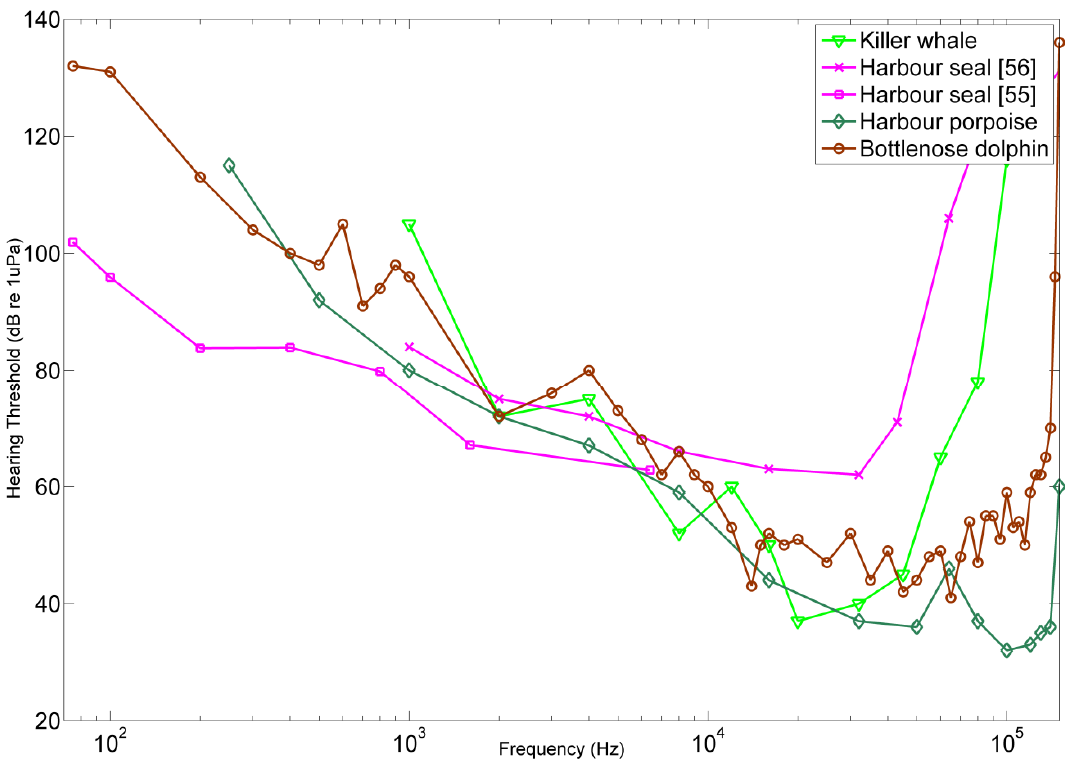
Figure 3. Hearing threshold audiograms of four different marine mammals, of which two ( P. vitulina and P. phocoena ) can be found in the Lysekil Research Site: killer whale ( Orcinus orca ) [54], harbour seal ( Phoca vitulina ), here two different studies are shown to cover more studied threshold frequencies [55,56], harbour porpoise ( Phocoena phocoena ) [57] and bottlenose dolphin ( Tursiops truncatus )